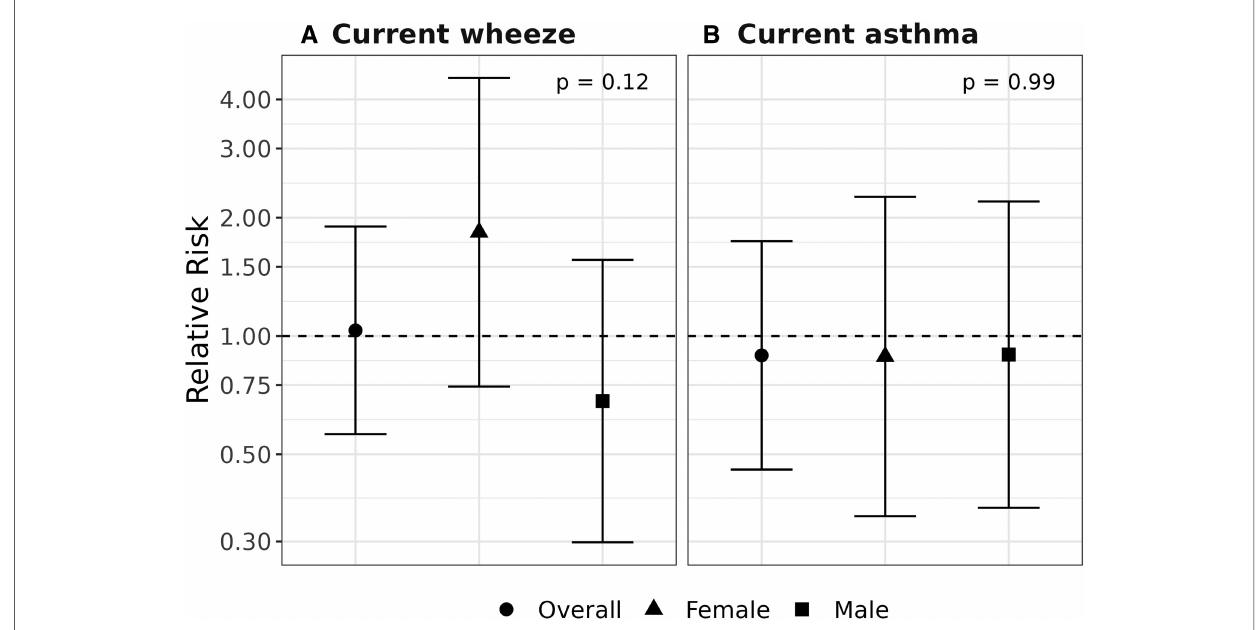
FIGURE 1 Assessment of effect modi fi cation by child sex. Relative risks (95% con fi dence intervals) are shown for overall, male- and female-speci fi c associations between prenatal exposure to cleaning chemicals and development of current wheeze ( A ) and current asthma ( B ) at age 4 – 6 years. Models were adjusted for child age, study site, maternal race, maternal ethnicity, education at enrollment, maternal history of asthma, maternal age at delivery, maternal self-report of smoking status at enrollment, household size category, region-and in fl ation-adjusted household income, postnatal second- hand smoke exposure, season of birth, fi rstborn status, child sex, and a multiplicative interaction term for exposure to cleaning chemicals by child sex.